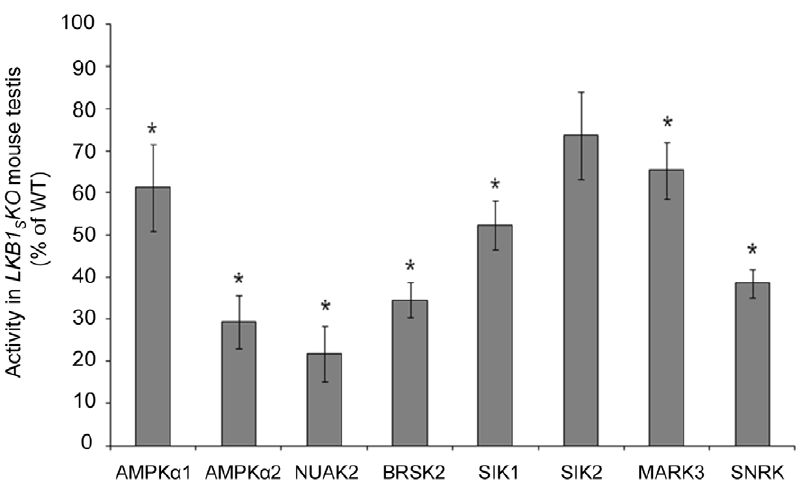
Figure 9. Activity of AMPK and AMPK-related kinases in LKB1 S KO testis. Activity measured in immune-complexes using antibodies specific for AMPK and AMPK-related proteins are plotted as a percentage of the activity measured in wild type testis and shown as the mean 6 S.E.M. from three individual mice. * indicates a statistically significant difference in activity in LKB1 S KO compared to wild-type samples ( p , 0.05 with Student’s unpaired t test).